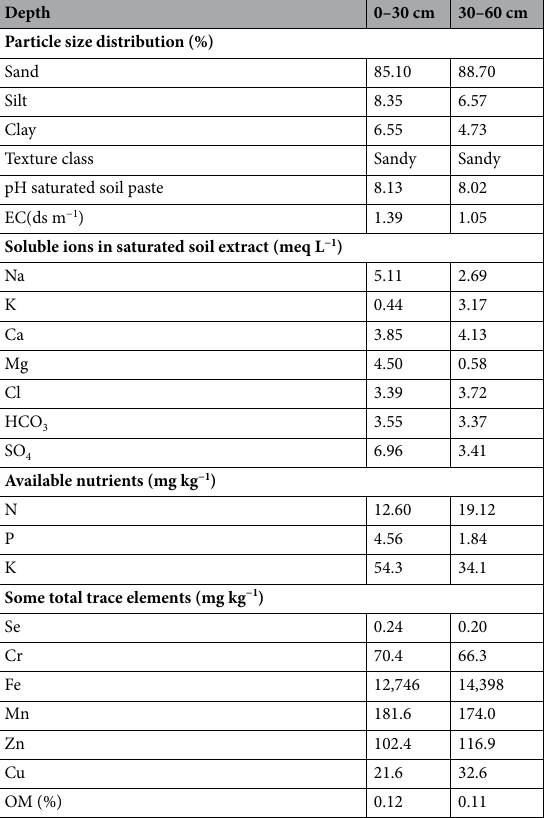
Table 1. Some chemical and physical properties of the studied